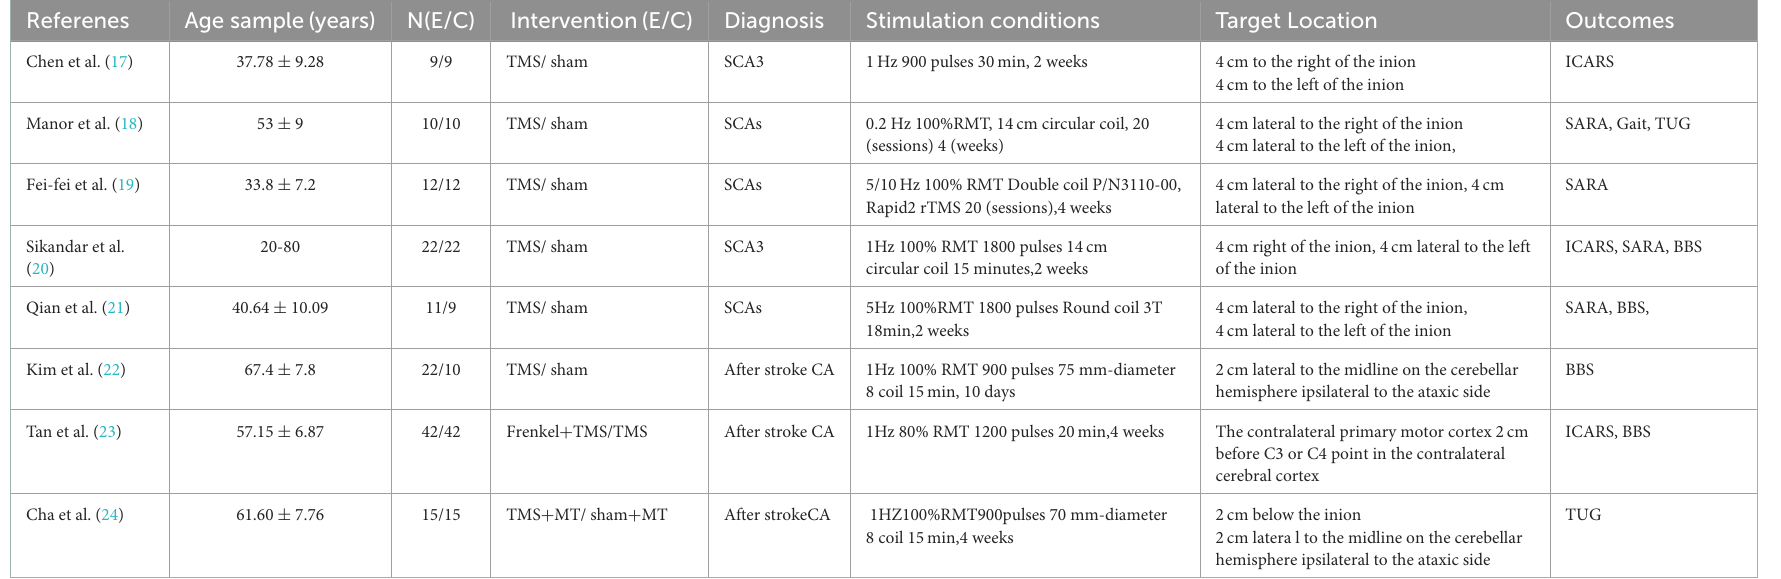
TABLE 1 Characteristics of included